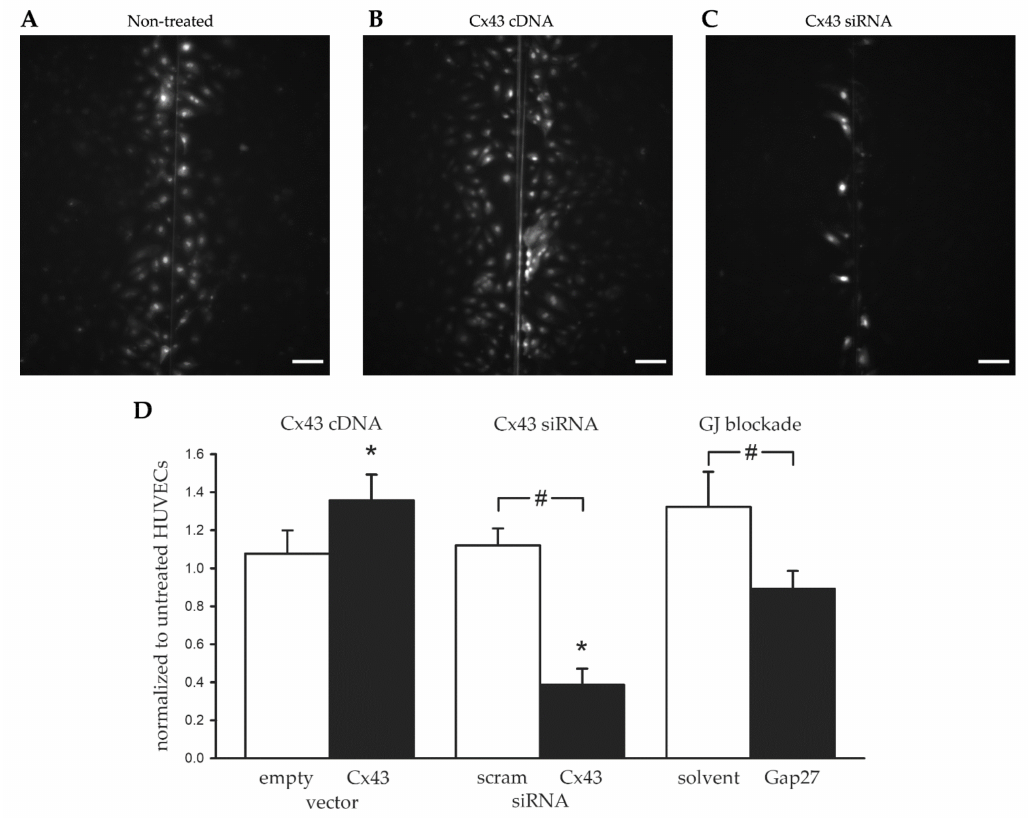
Figure 1. Dye transfer was modulated by Cx43 expression and GJ blockade. The representative images show dye transfer after scrape loading in non-treated controls ( A ), Cx43 cDNA transfected cells ( B ), and cells treated with Cx43 siRNA ( C ). Scale bar is 100 µ m. The summary data in ( D ) are normalized to paired sample values obtained in non-treated HUVECs. The treatment groups are shown in black, and the respective controls are shown as white bars. Transfection with Cx43 cDNA enhanced the dye transfer, which was not found after transfection with an empty vector (left, n = 7). The scrambled siRNA (scram) had no effect, whereas Cx43 siRNA strongly decreased dye transfer (middle, n = 8). Dye transfer was significantly attenuated in cells treated with Gap27 compared to the solvent controls (right, n = 6). * p < 0.05 vs. non-treated HUVECs (paired t -test), # p < 0.05 vs. sham-treated control cells (paired t